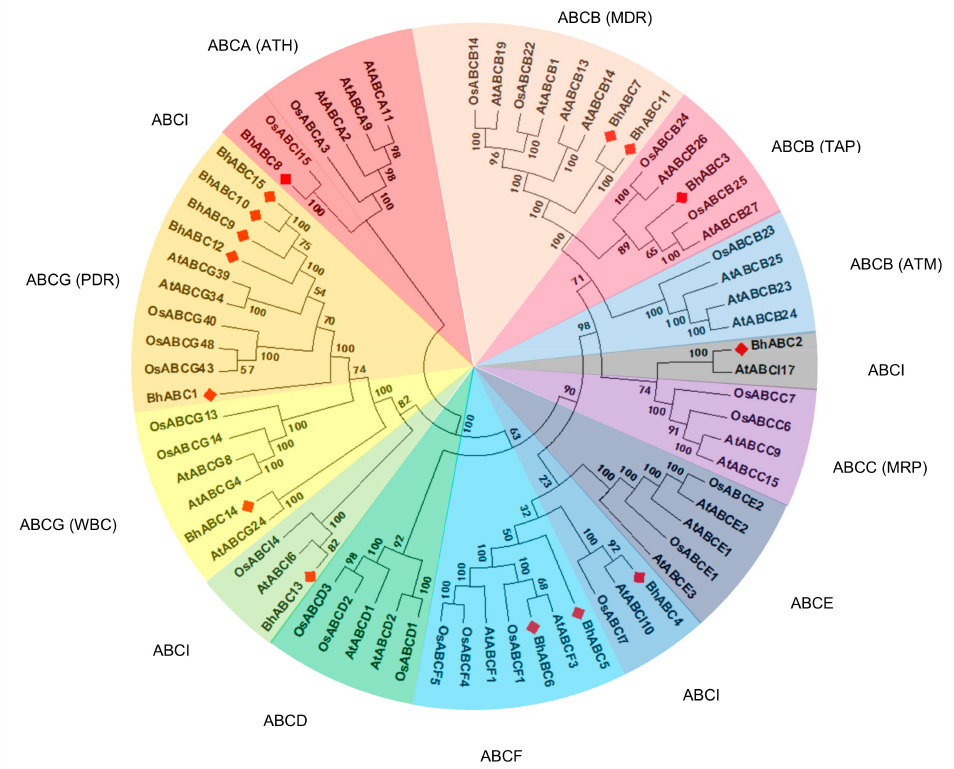
Figure 2. Phylogenetic tree of ABC transporter proteins (BhABC transporters noted with red / orange diamonds). Phylogenetic subclasses are marked with di ff erent colors and corresponding subfamily names. The phylogenetic tree was drawn using MEGA 5.0 and was based on the following parameters: neighbor-joining tree method, complete deletion, and 500 bootstrap replicates. OsABC denotes Oryza sativa ABC proteins (including 24 members), AtABC denotes Arabidopsis ABC proteins (including 29 members), and BhABC denotes B. halophila ABC proteins (including 15 members). Numeric values indicate estimated evolutionary